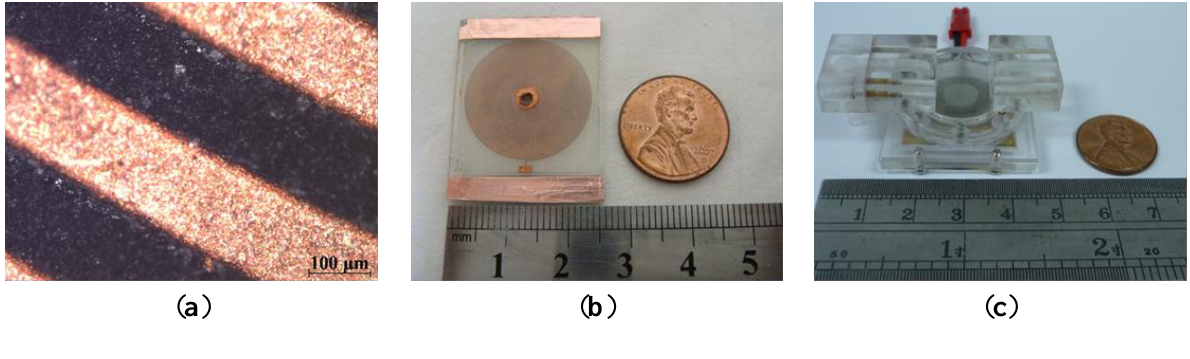
Figure 3. Photographs of: ( a ) microcoil surface, ( b ) microcoil on lower glass plate, and ( c ) completed pump.